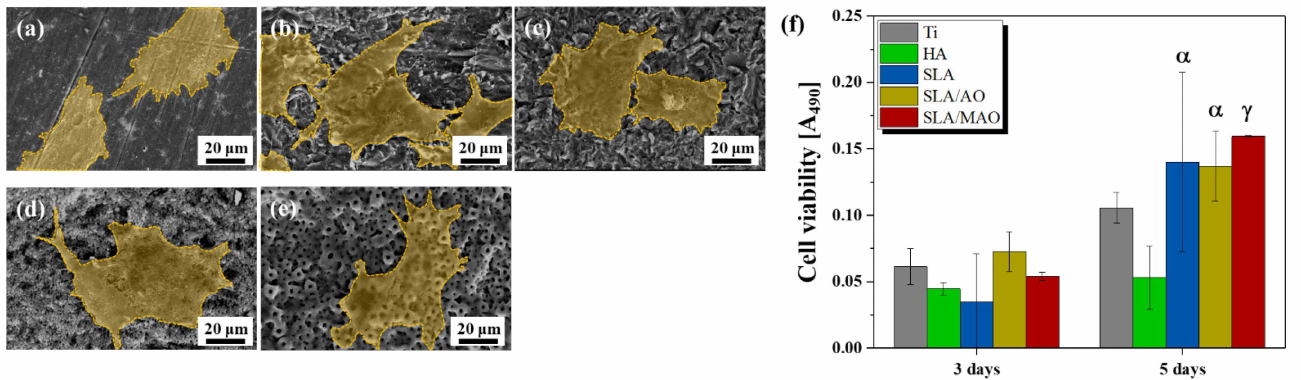
Figure 7. SEM images of attached pre-osteoblast cells on ( a ) Ti, ( b ) HA, ( c ) SLA, ( d ) SLA/AO, ( e ) SLA/MAO, and ( f ) measured degree of cell proliferation ( α denotes p < 0.05 and γ denotes p < 0.01 compared to HA at 5